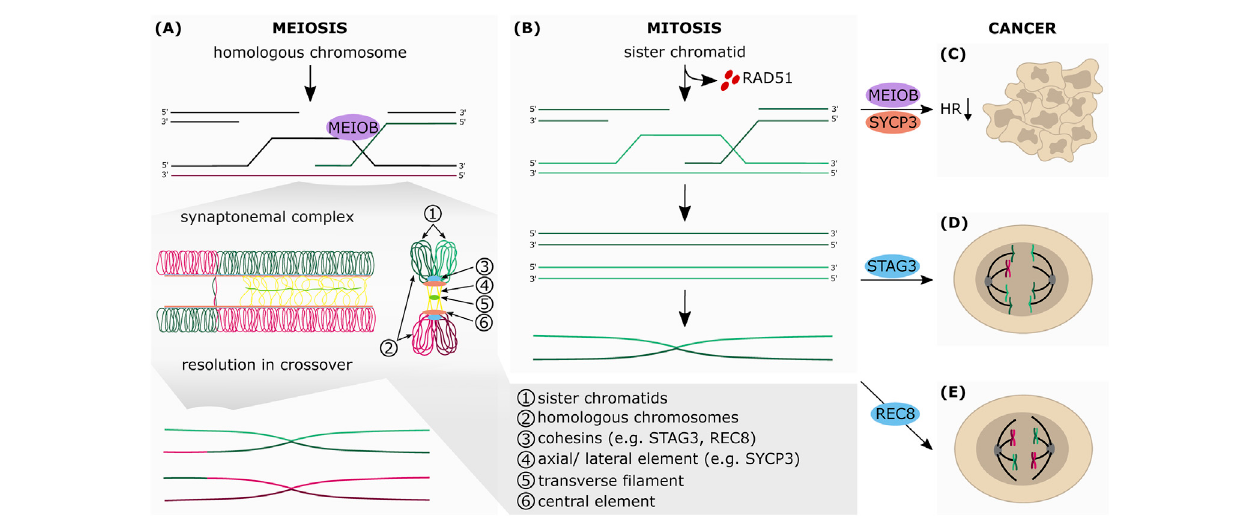
FIGURE3 | The aberrant expression ofmeiotic genesin somatic cancersaffects HR-dependent-DNA repair. Simpli fi ed schematic representation of the fi nal steps ofHRinmeiosis (A) andmitosis (B)(A) Duringmeiosis,thesisterchromatids(1)areconnectedwitheachotherbythecohesincomplex(3).Cohesinsarealsoessentialfor the formation of the synaptonemal complex (SC), which connects the homologous chromosomes (2). The SC consists of the axial elements (AEs) of the chromosomes (4), which are connected to each other by transverse fi laments (5) and the central element (6). Upon formation of the SC, AEs are turned into lateral elements (LEs), which consist of two different SC proteins: SYCP2 and SYCP3. Between the AEs of the two homologous chromosomes SYCP1 builds parallel dimers that stabilize the positioningofthehomologouschromosomes andfavorcrossovers. Theexonucleolytic activityofMEIOB allowstheformationofadouble Holliday junctionbetweentwo homologous chromosomes which can be resolved in both non-crossover and crossover formation (B) The RAD51-ssDNA fi laments search for homologous DNA template byinvadingthe sisterchromatid, which leadsto theformationofthe Holliday junctions and fi nallytoDNA synthesis ofthe missing sequence that waslost at the breakpoint. Aftersynthesis, thejunctionsareresolved byendonucleolyticcleavage, theinvadingstrand isreleased andannealstotheothersideofthebreak.Therepair is completed by ligation of the gaps by a DNA ligase (C) Aberrant expression of MEIOB and SYCP3 in somatic cancers inhibits HR-mediated DNA repair (D) STAG3 altered expressionmediateschromosomalmis-segregationandgenomereductionofcancercells (E) AugmentedexpressionofREC8insomaticcancercellspromotes meiosis-like reductional segregation of homologous chromosome, which provides a survival advantage following DNA damage-inducing